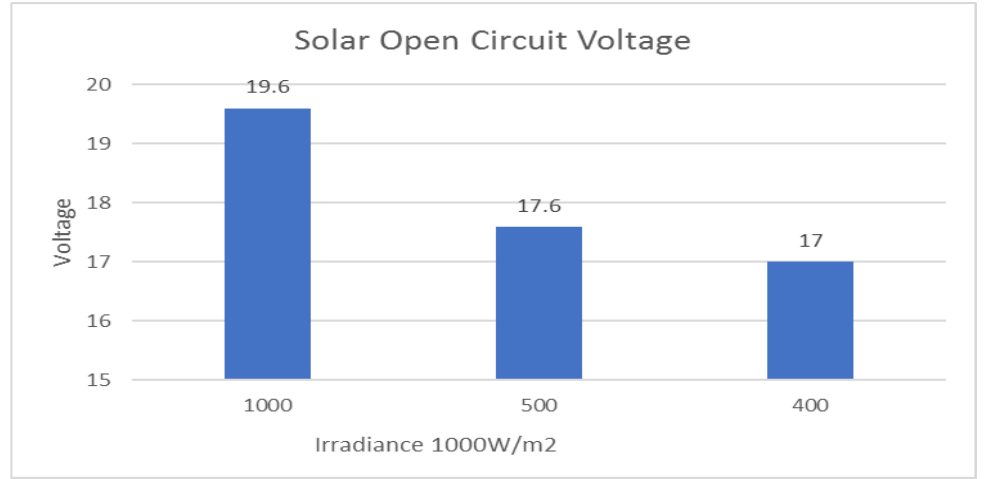
Figure 7. Open circuit voltage of solar panel under various condition of solar